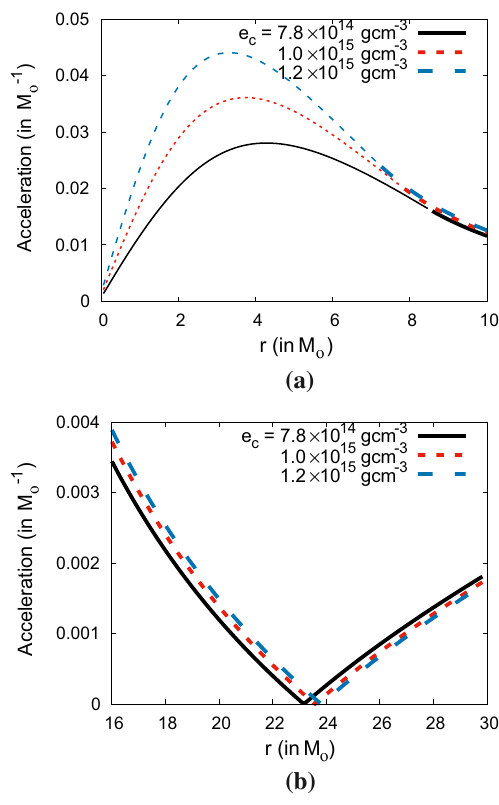
Fig. 6 a Magnitude of acceleration with distance from centre along the equitorial plane around NSs with varying central density. The blue dashed line is for central density of 1 . 2 × 10 15 g cm − 3 , the red short dashed line is for 1 . 0 × 10 15 g cm − 3 and the black solid line is for 7 . 8 × 10 14 g cm − 3 . Here the value of Ω is taken to be 2000 rad s − 1 . The NS’s angular velocity is 3000 rad s − 1 . The plotting format (bold, thick lines for star exterior and thin lines for the star interior) is done to show the distinction between the interior and exterior regions clearly. b Variation of acceleration with respect to distance at the exterior region of NS. The texture and color of plots follow same nomenclature as a